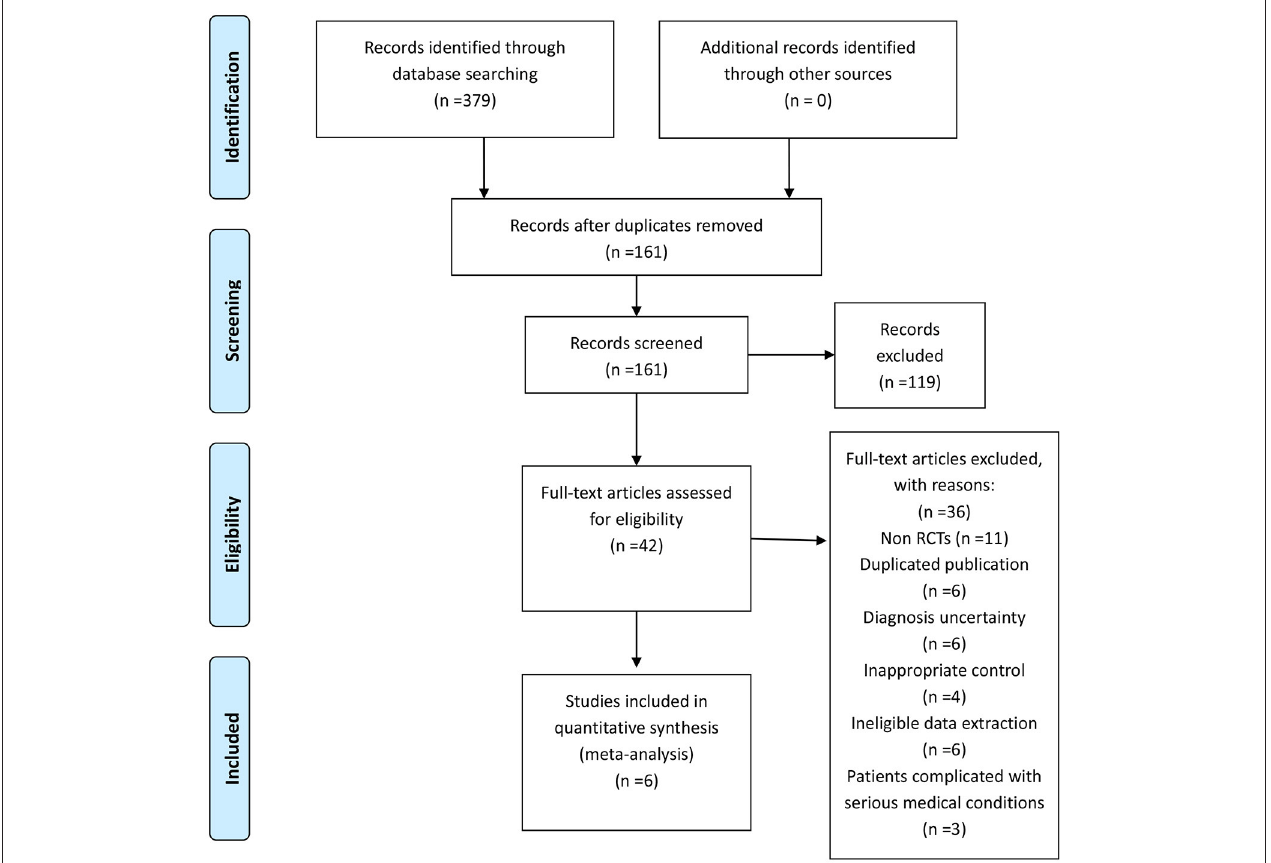
FIGURE 2 | Flow diagram of the literature searching and study selection.